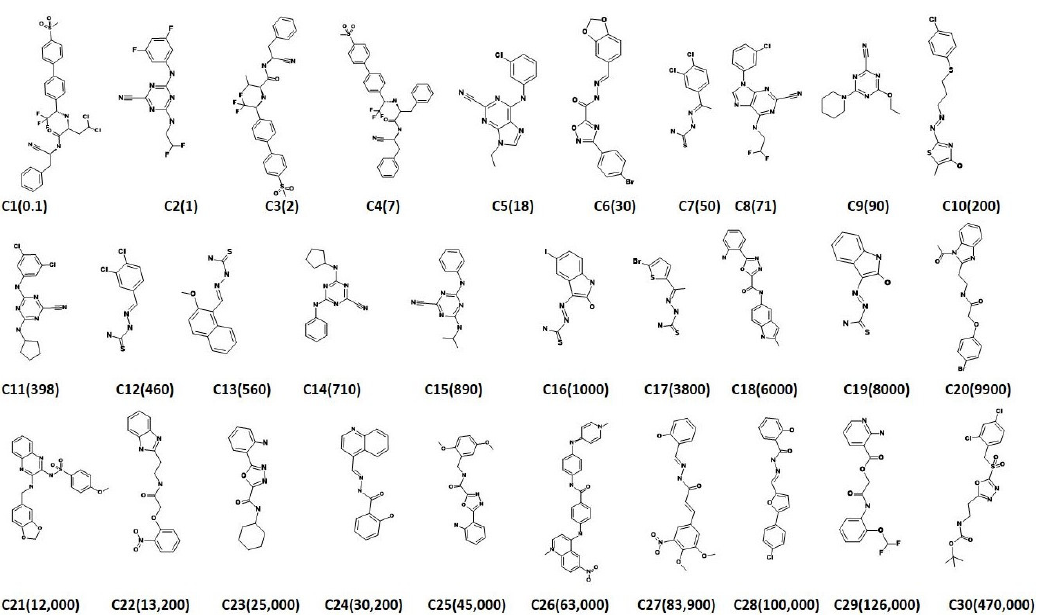
Table 1. Statistical and predictive significance presented in cost values for top 10 hypotheses generated due to 3D QSAR pharmacophore modelling.